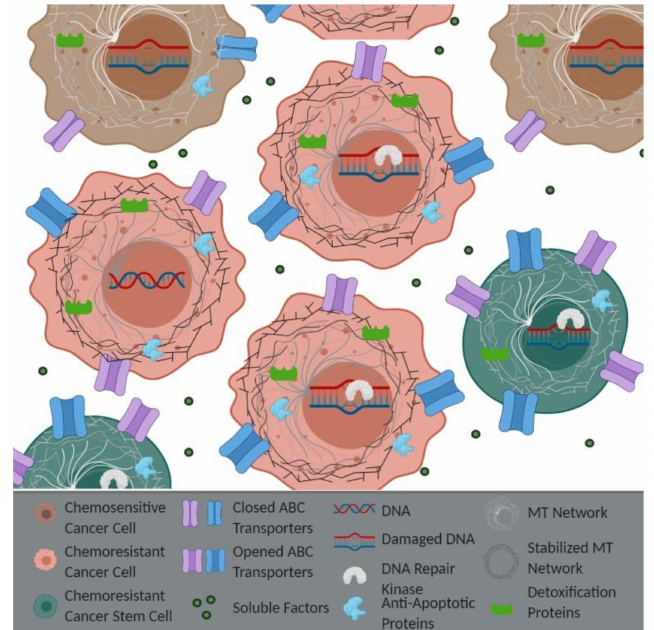
Figure 1. Epithelial-Derived Resistance: Intracellular resistance can occur though di ff erent mechanisms. Active (open) ATP binding cassette (ABC) transporters on the chemoresistant cells are responsible for the e ffl ux of drugs. Decreased drug-induced DNA damage and enhanced DNA repair kinase expression and / or activity prevent the induction of apoptosis. An increased expression of anti-apoptotic proteins, alterations in detoxification systems, altered microtubule (MT) networks, and various cell–cell interactions can also contribute to drug resistance. Images made with